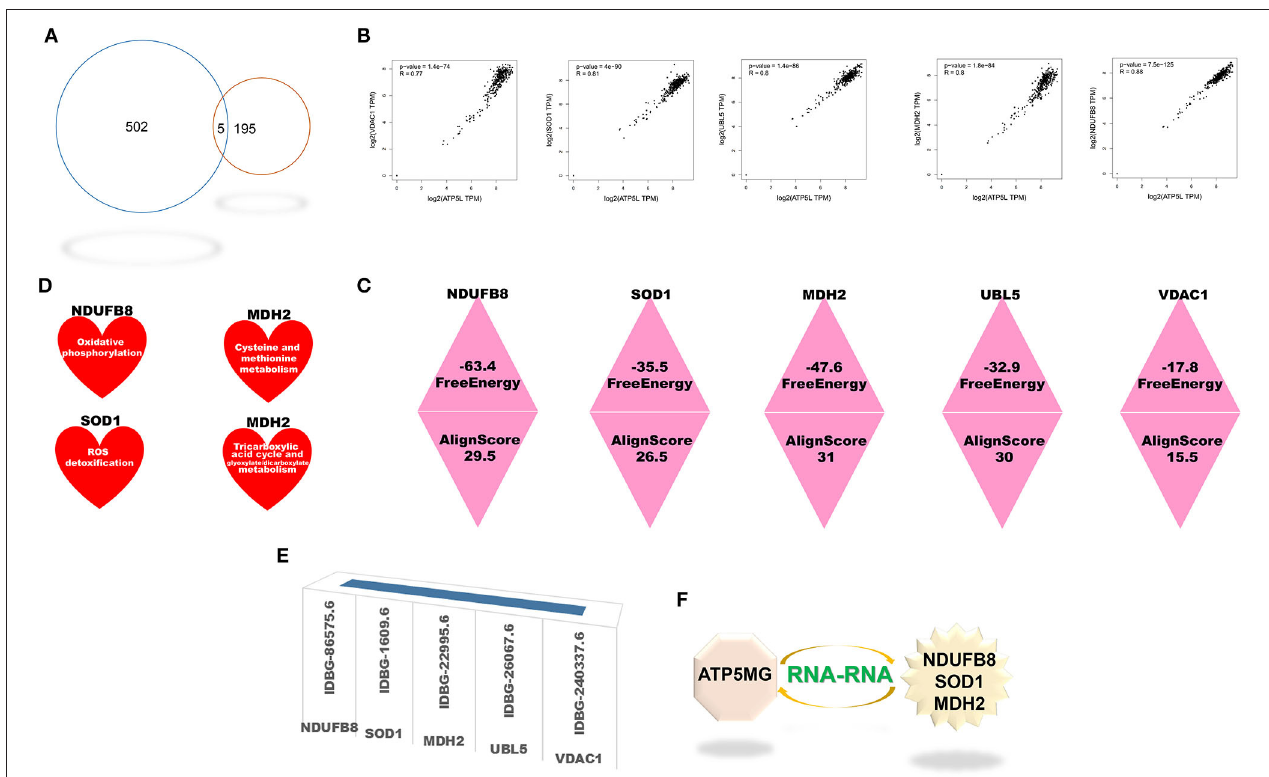
FIGURE 6 | Intersection genes between coexpression and RNA-RNA-interacting genes of ATP5MG. Five intersection genes were mined for coexpression and RNA-RNA interaction gene sets of ATP5MG. The strength of the interaction is assessed. Metabolic and immune annotations were retrieved. (A) Genes numbers of distinct datasets. (B) Expression relations between ATP5MG and intersections. (C) Strength of the interplay of five intersection genes. (D) NDUFB8, SOD1, and MDH were annotated in the metabolic database. (E) Five cross genes were registered in innateDB. (F) ATP5MG-interplayed gene